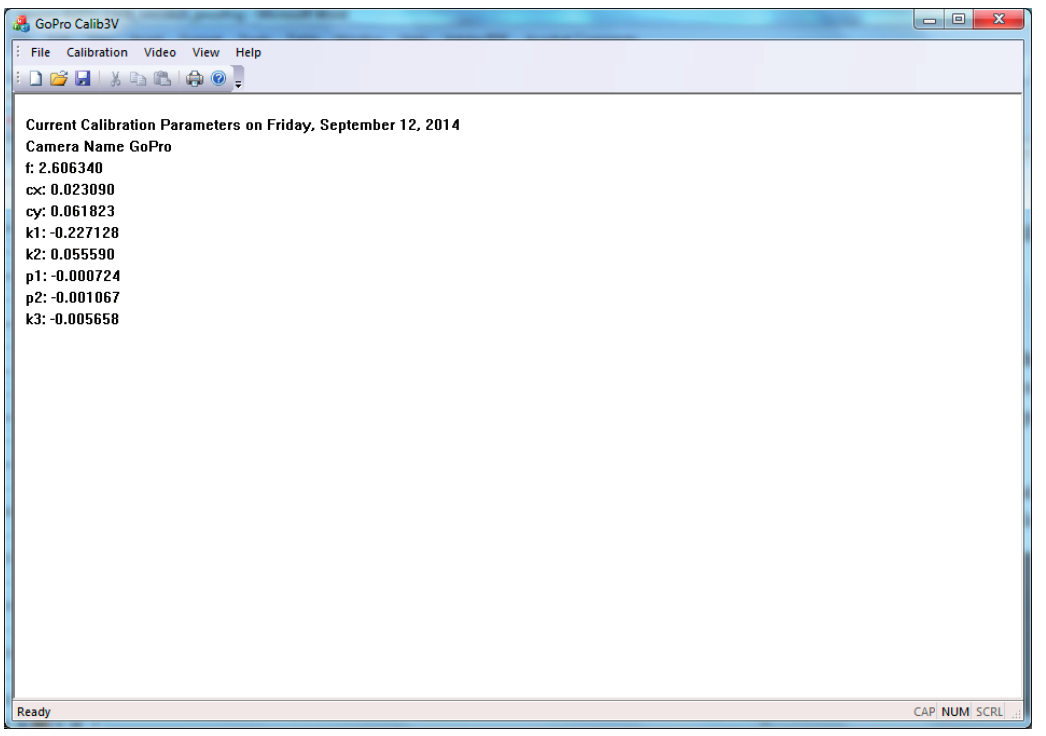
Figure 11. Calibration parameters as they are calculated for the 12 Mpixels still images from the GoPro Hero 3